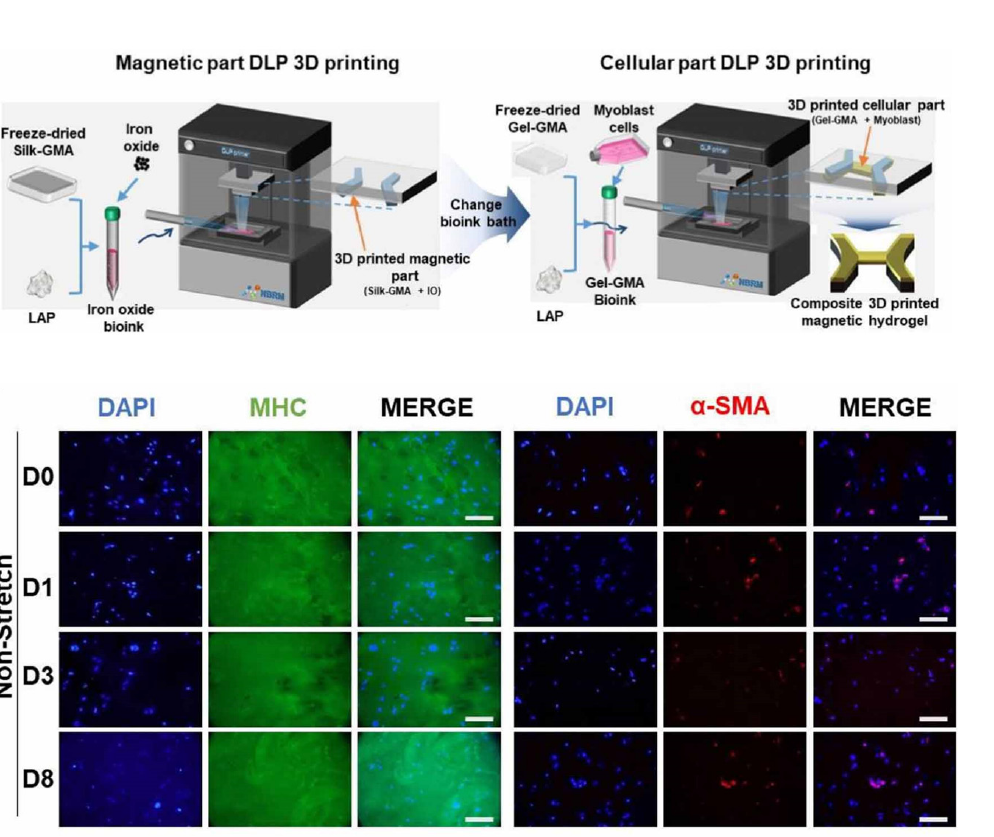
Figure 7. The fabrication process of magnetic hydrogel and the effect of magnetic bioreactor on magnetic hydrogel encapsulated myoblast cells. ( a ). Graphical presentation of the construction pro- cesses of the magnetic bioreactor in the 3D DLP printer. Silk-GMA + IO was used as a base layer bio-ink, while the top layers were printed with Gel-GMA + myoblast cells. Silk-GMA: methacrylated SF, Gel-GMA: methacrylated gelatin, GMA: glycidyl methacrylate, IO and O=Fe=O: iron oxide. ( b ). Fluorescence pictures exhibited myosin (MHC-green) and α -SMA (red) expressions for C2C12 cul- tured hydrogel in both static and stretched conditionThe alignment of the myotubes and α -SMA was similar to the direction of hydrogel. Adapted from [103] with the permission from IOP Pub- lishing Ltd.